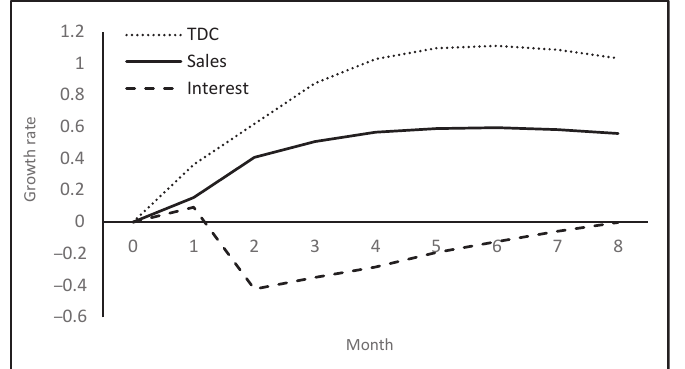
Figure 8. IRF price over TDC, sales and interest